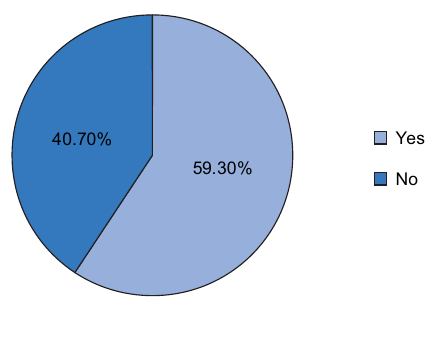
Figure 7: Adherence to exercise.